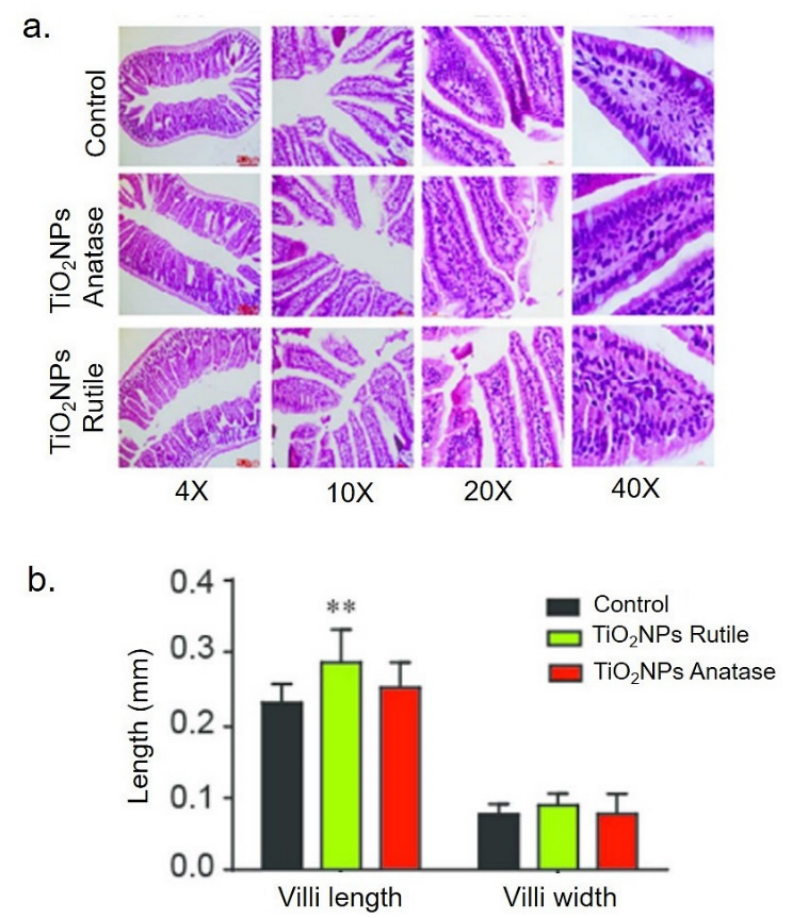
Figure 5. ( a ) Histological acquisitions of mouse colon tissue at different magnifications (4, 10, 20, and 40×) after Hematoxylin and Eosin staining. ( b ) Quantitative intestinal villi length and width ratio analysis. Data were statistically significant for **p < 0.05 compared to the control group. Adapted from [130] with Permission of the Royal Society of Chemistry, Copyright 2018.